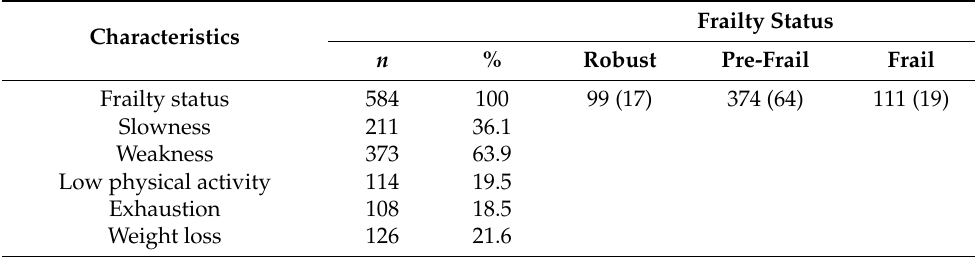
Table 2. Prevalence of frailty status and components ( n =